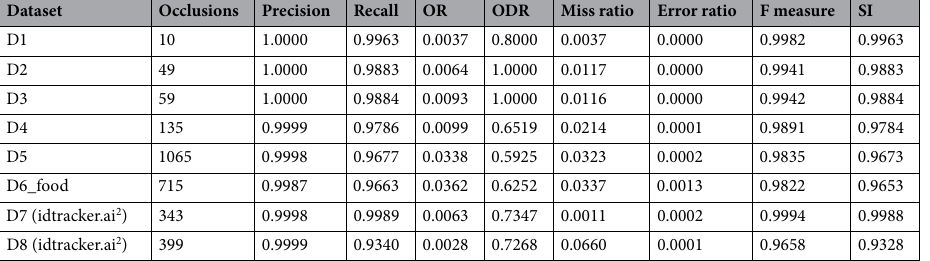
Table 2. Performance of the detection evaluation.